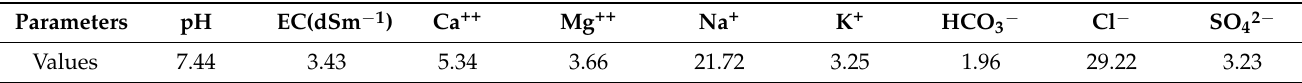
Table 2. Chemical characteristics of irrigation water used for the present study.